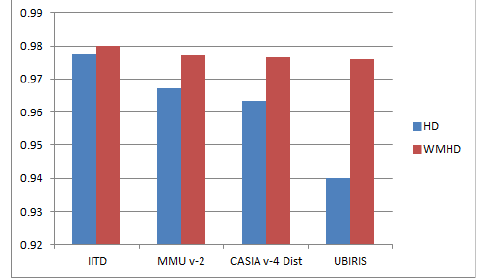
Figure 3. RI showing that, with respect to all databases, WHMD is more reliable than normal Hamming distance.